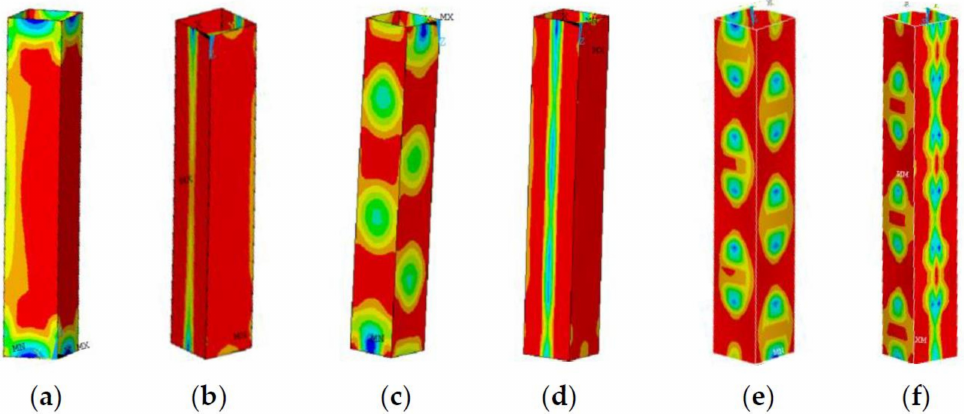
Figure 15. The buckling equivalent stress cloud diagram when λ = 15. ( a ) b / t = 10, ( c ), b / t = 30, and ( e ) b / t = 50 without residual stress; ( b ) b / t = 10, ( d ) b / t = 30, and ( f ) b / t = 50 with residual stress.